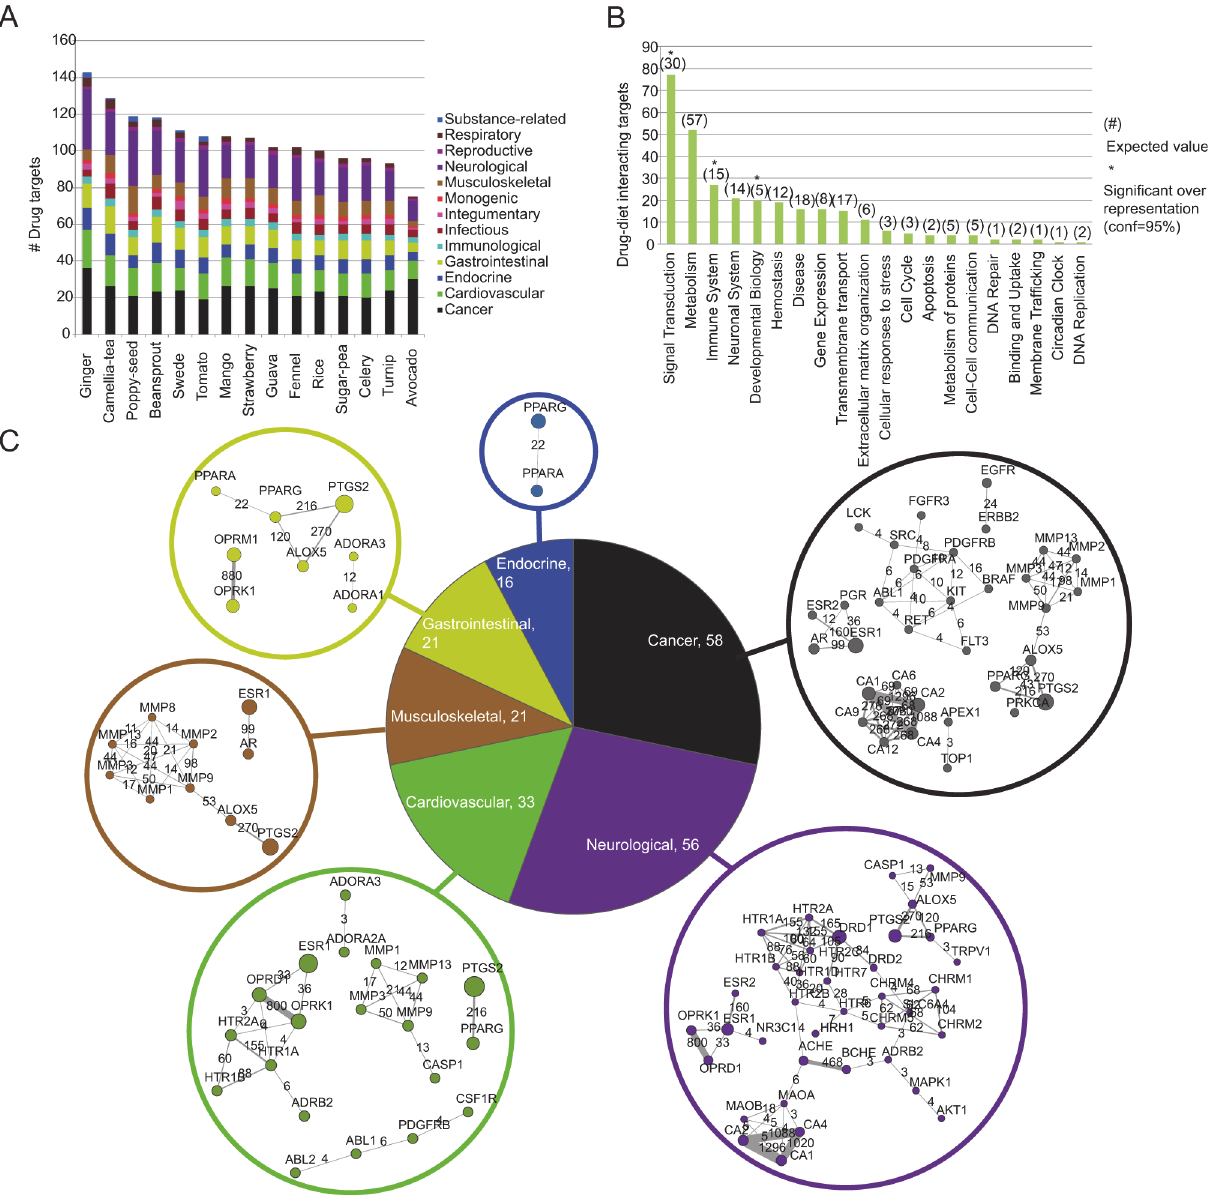
Fig 2. Drug-food interactions affecting drug pharmacodynamics. (A) The plot shows the plant-based foods with the highest number of interactions with drug targets and their associated human disease classification. (B) The number of drug targets affected by food, annotated to different biological systems. The expected number of targets in each biological category was calculated as: exp = (tpc / tdt) * tpa, where, tpc: the total number of drug targets from DrugBank in a biological category, tdt: the total number of drug targets in all biological categories (1,806 proteins) and tpa: the total number of drug targets that participate in drug-food interactions based on our analysis (186 proteins). (C) Networks of drug targets affected by food, per human disease class, shown for the 6 disease classes with the highest number of drug targets involved in food interactions. Two drug targets are connected when there are at least 3 drug- food pairs with biological activity against both proteins. The numbers inside the pie correspond to the total number of drug targets under each disease class that are affected by food. For visualization purposes, we show only the top 5 edges for each node, while the complete data are provided as supplementary material (S2